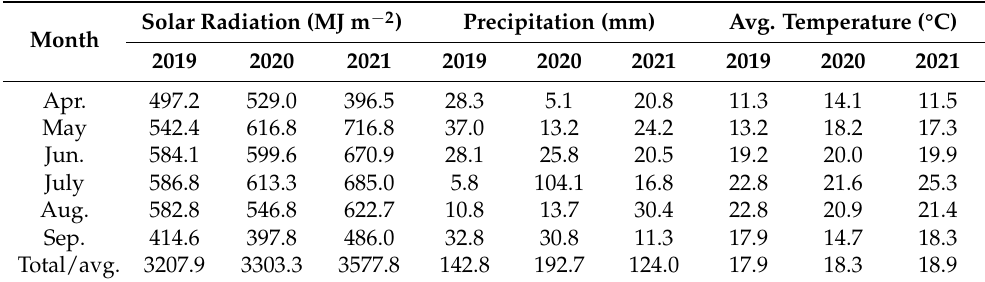
Table 1. Solar radiation, precipitation, and average temperature in the maize growing seasons from 2019 to 2021.